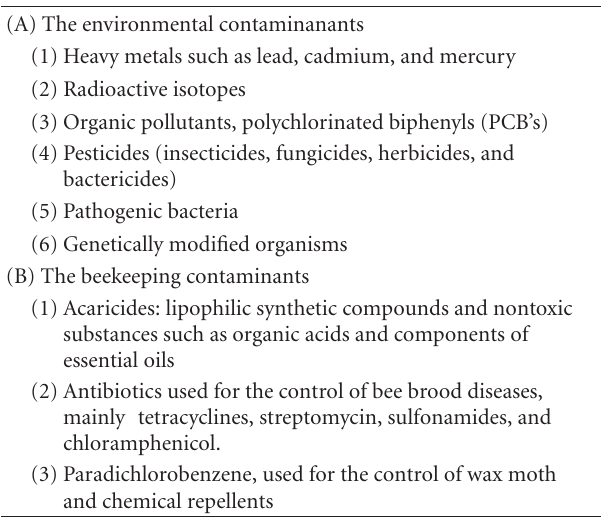
Table 1: Types of honey’s